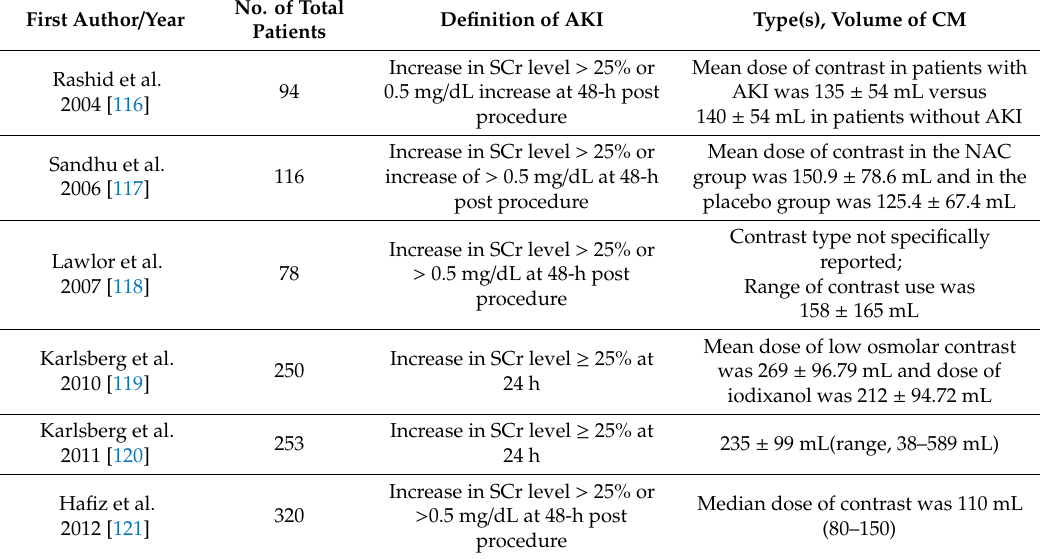
Table 4. Prospective randomized studies on AKI in patients undergoing lower extremity angiography and / or endovascular therapy for peripheral artery disease